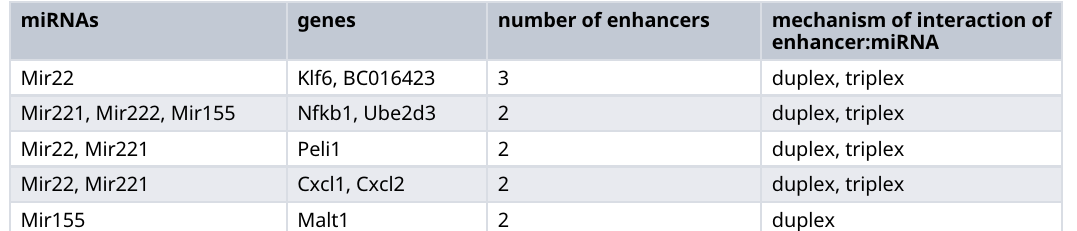
Table 1. The most promising miRNAs predicted for M0 infected BMDMs to upregulate genes via enhancer activation. miRNAs